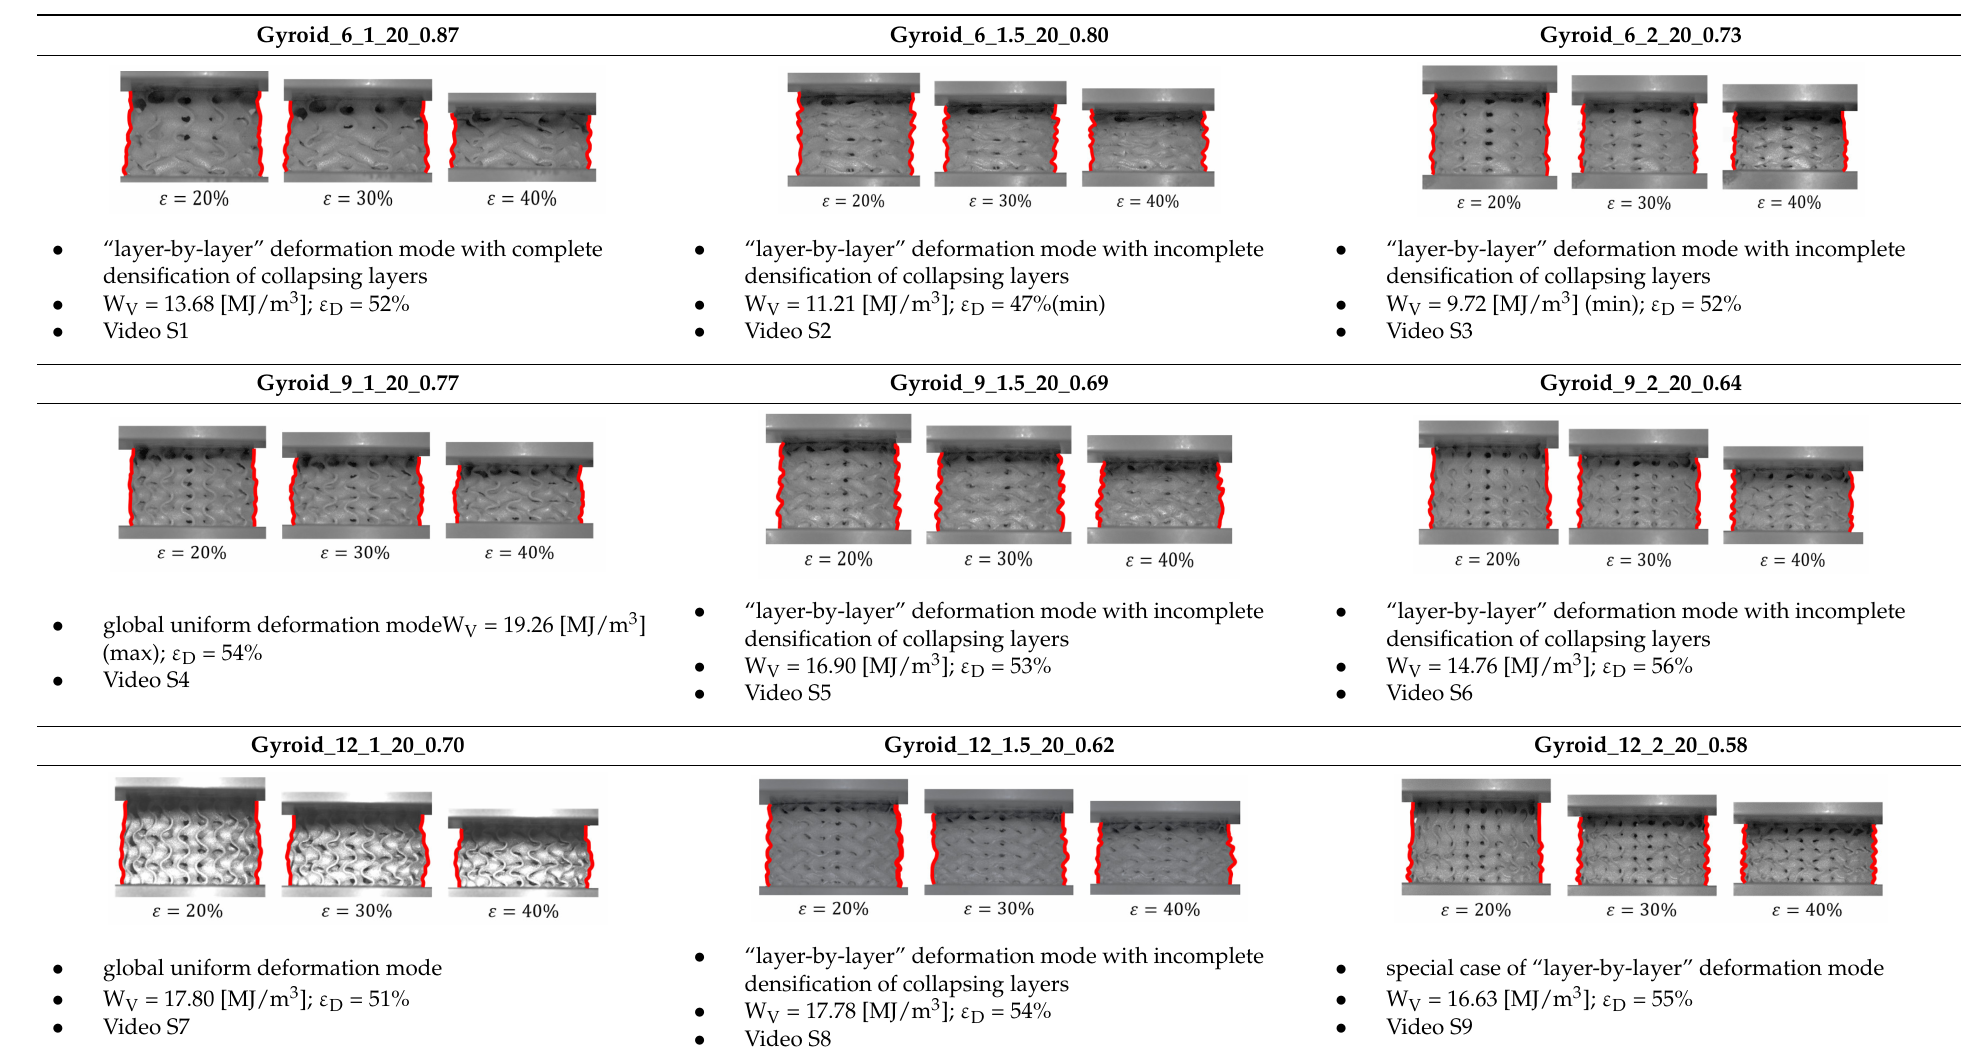
Table 6. Classification of the tested samples to the observed deformation